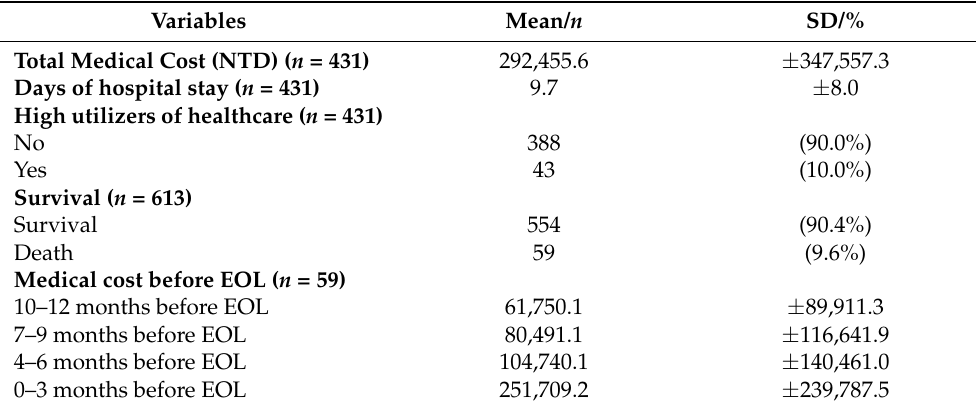
Table 2. Medical cost, healthcare resource utilization, and mortality in COPD